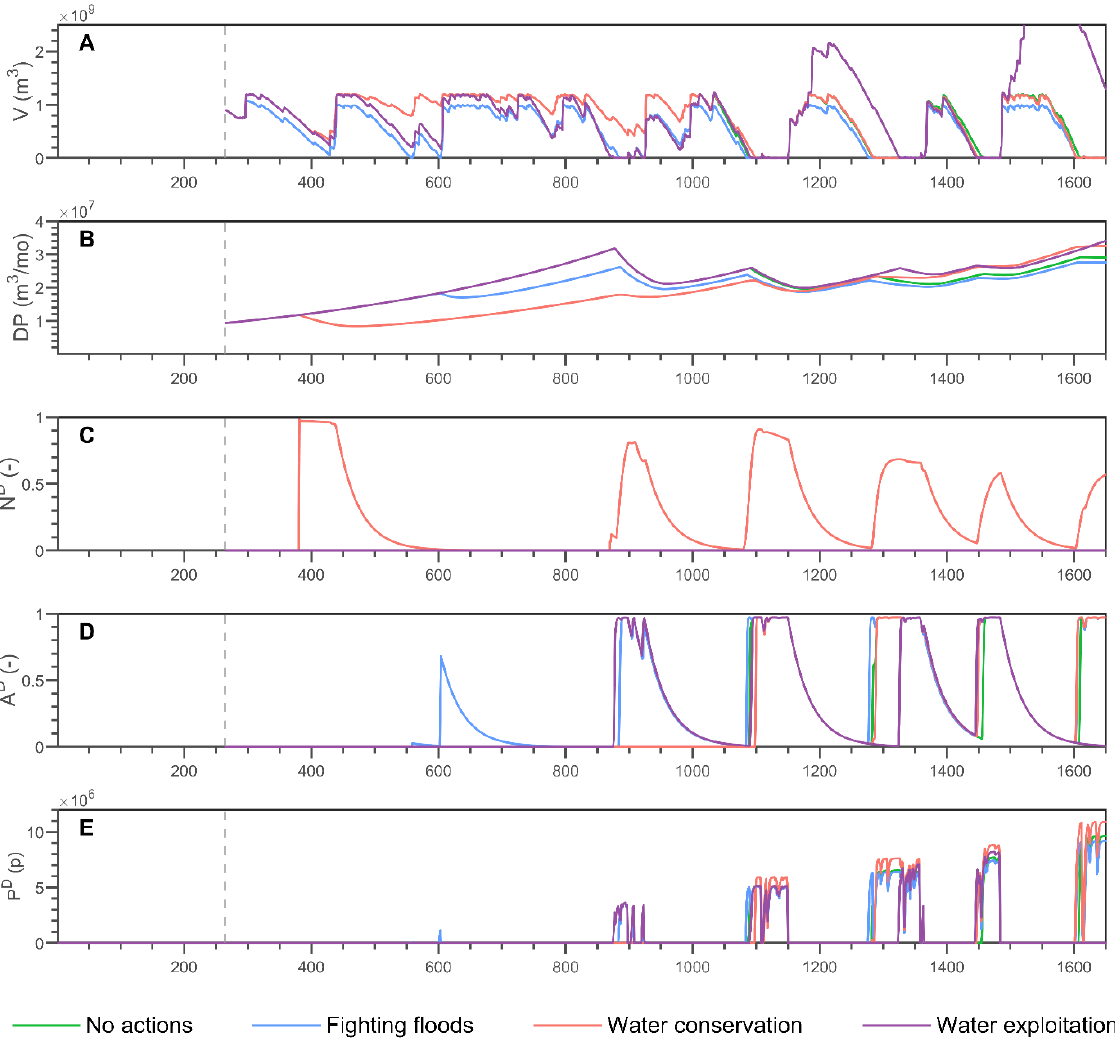
Figure A15. Water shortage-based variables of the synthetic experiments additional scenario #4 considering dam construction and human-flood interactions with the four water management strategies introduced in this study. (A) reservoir volume (V), (B) total water demand (DP), (C) willingness to the new per-capita demand (ND), (D) drought awareness (AD), and (E) population affected by droughts (PD). The grey dashed line indicates the construction of the Wivenhoe